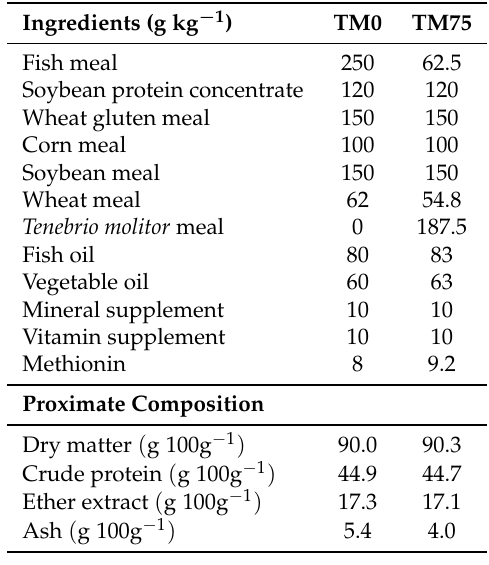
Table 1. Ingredients and composition of TM0 and